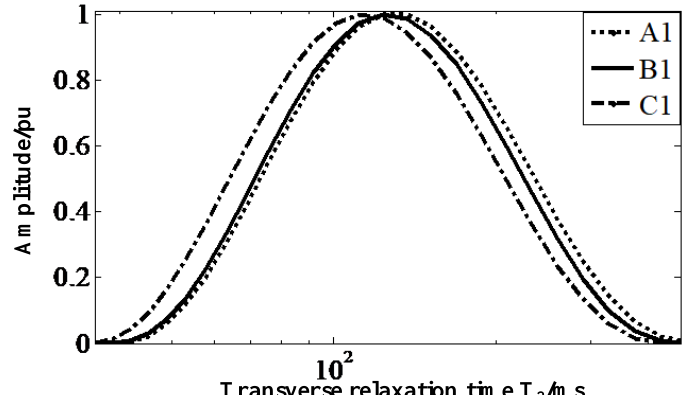
Figure 14. T 2 distribution of the samples.